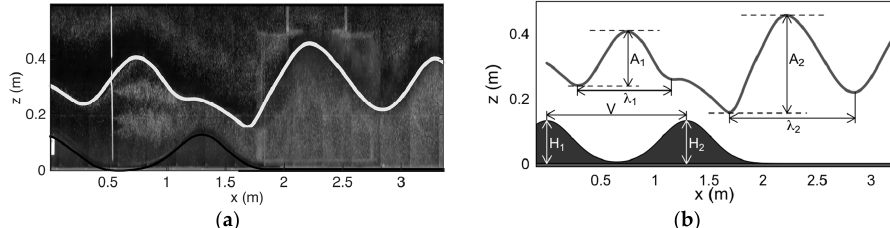
Figure 3. ( a ) Example of interface detection for experiment 240; ( b ) Schematic diagram showing the definition of variables used in the text.